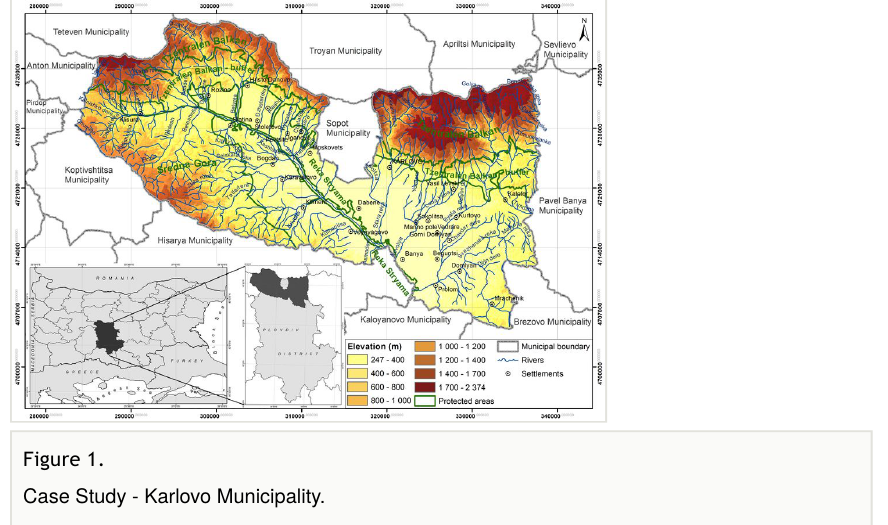
Case Study - Karlovo